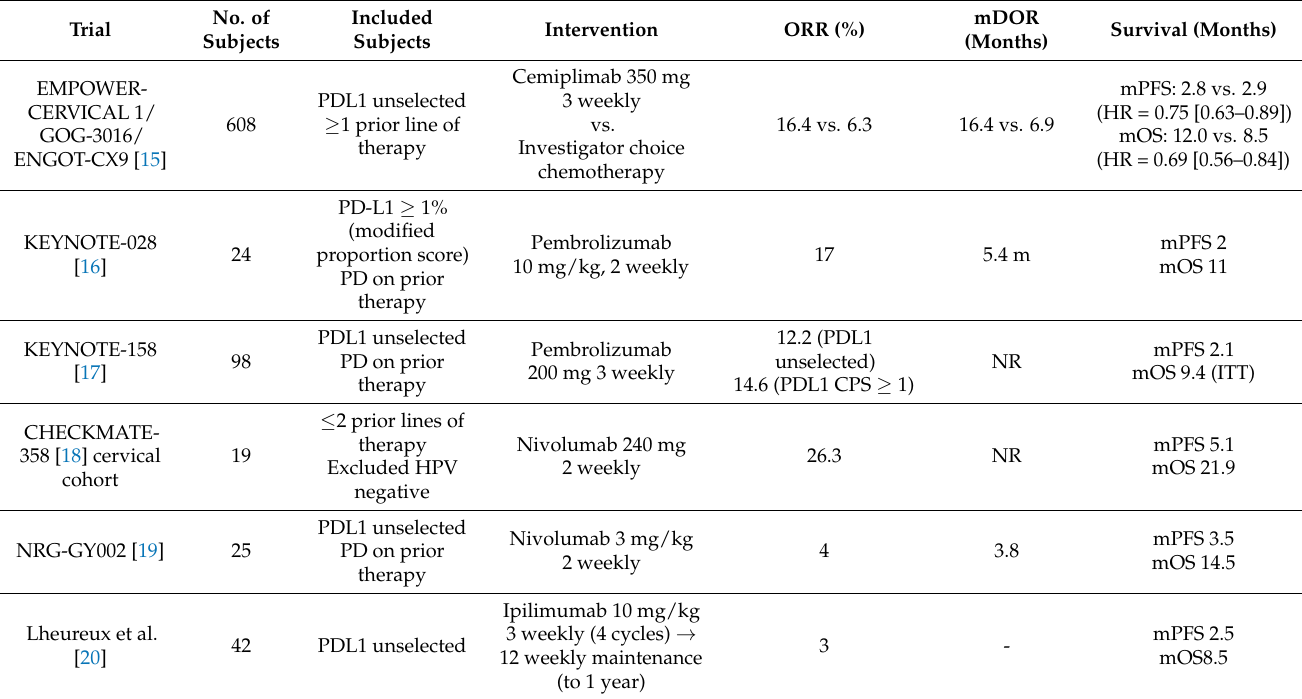
Table 1. Reported trials of ICI single agent therapy in advanced cervical